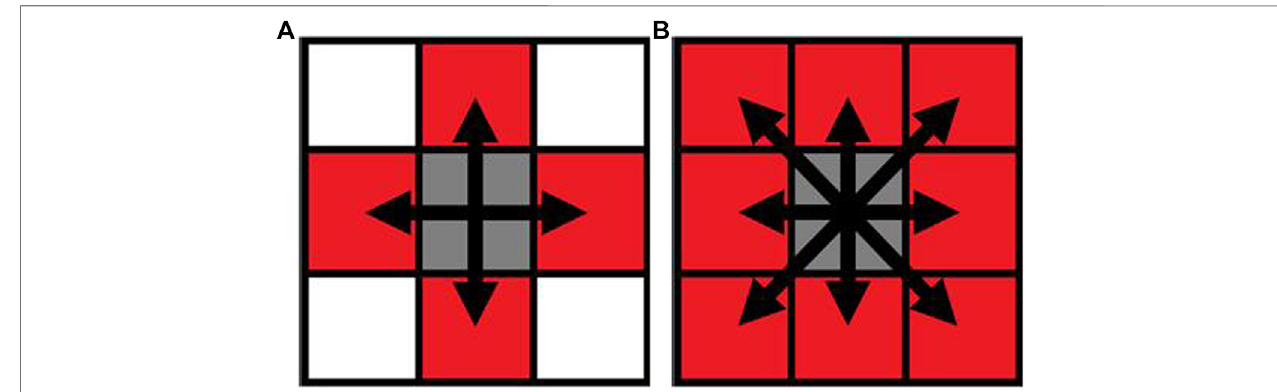
FIGURE4 | Pixel neighborhood analysis for bone-scaffold connection percentage ( (A) 4-connectedneighborhood; (B) 8-connected neighborhood).Simulation of scaffold recruitment for bone marrow mesenchymal stem cells.